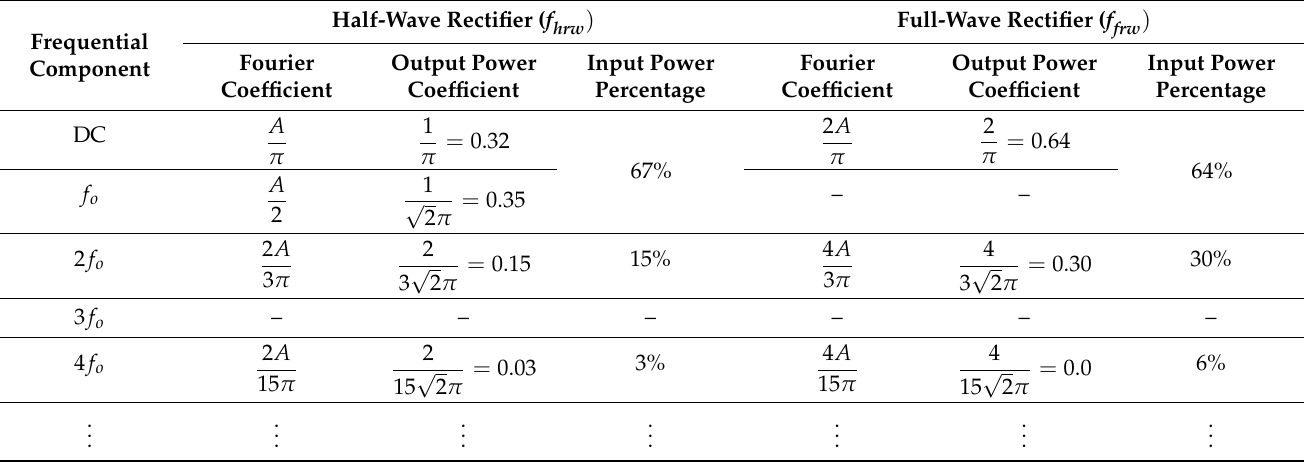
Table 2. Harmonic coefficients of the full- and half-rectifier waves and the associate power.